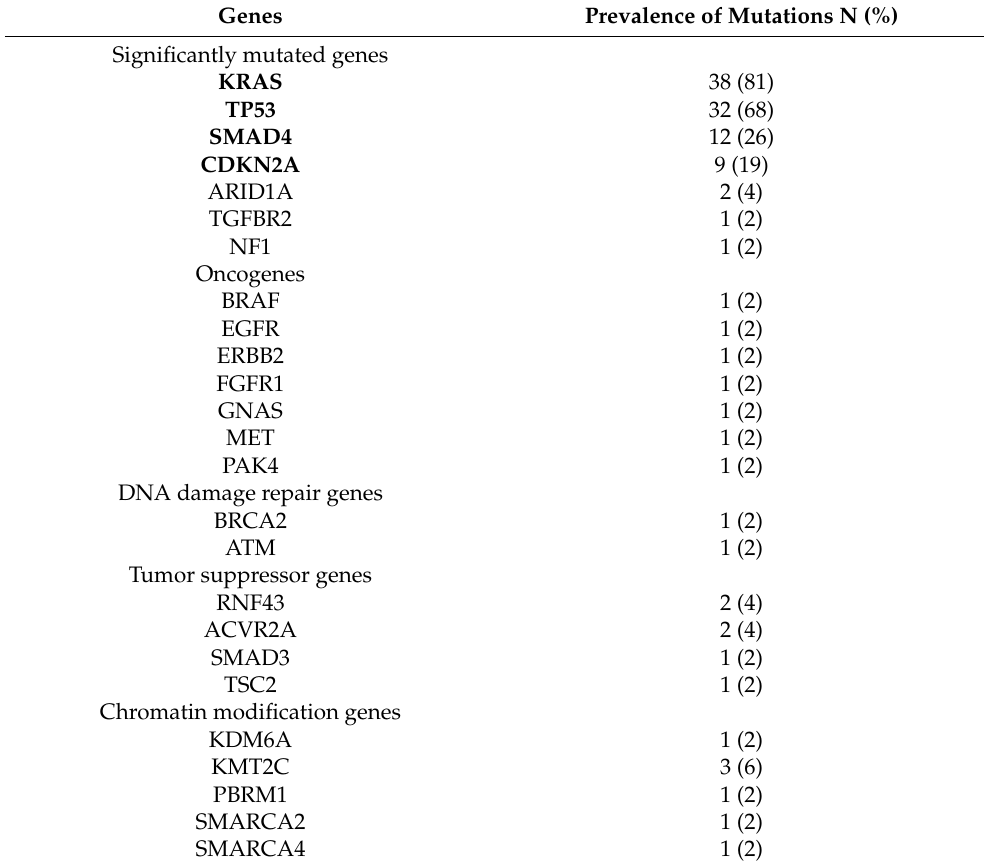
Table 2. Prevalence of genomic alterations in PDAC resection specimens. The 4 most prevalent gene mutations are presented in bold.